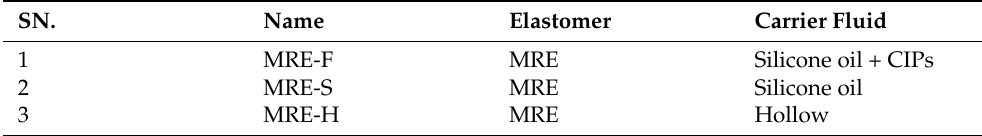
Table 2. The naming of the fabricated hybrid MRE samples.